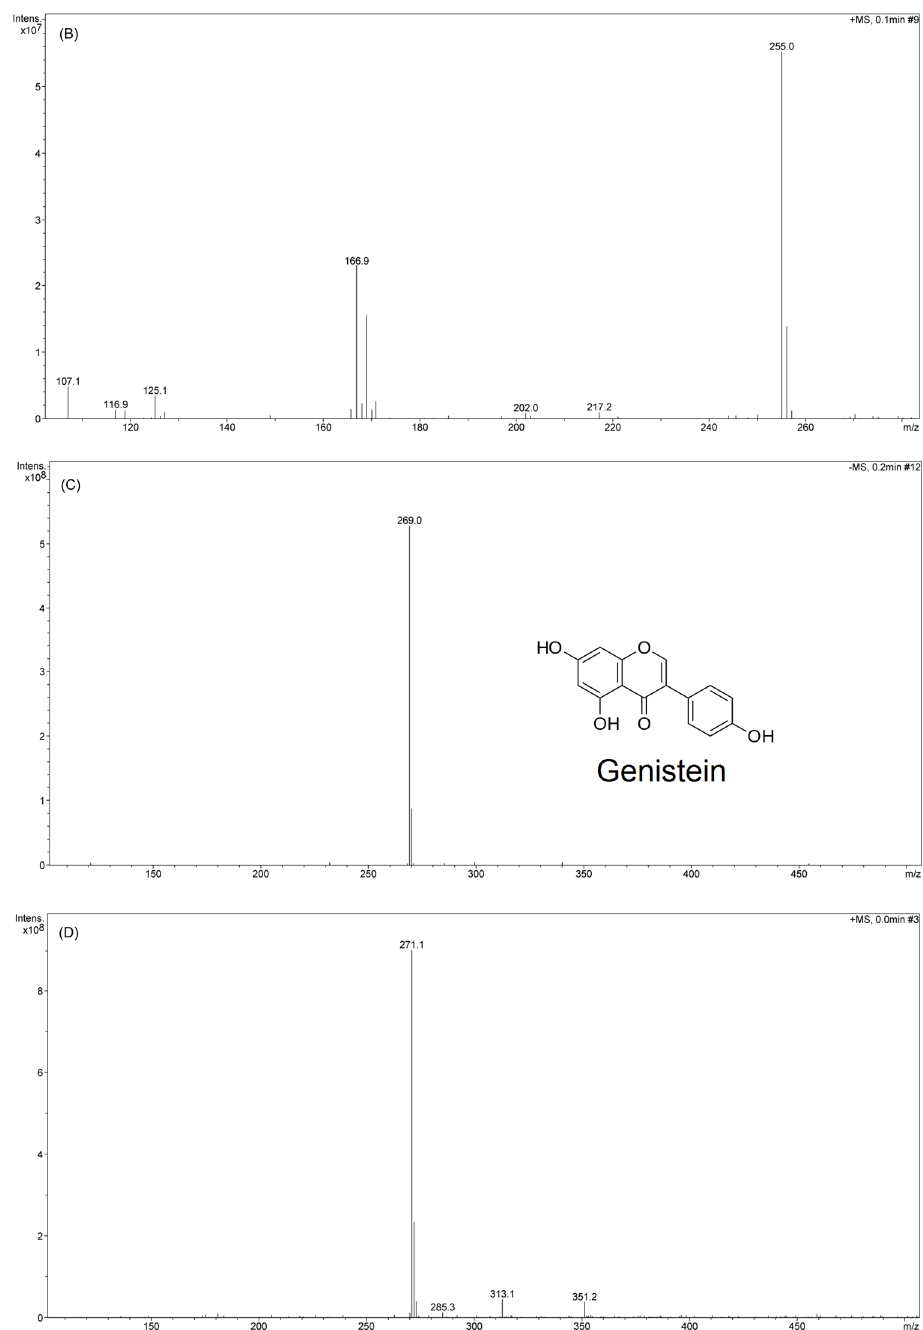
Figure 6. LC-MS / MS spectra of daidzein and genistein. Negative mode of daidzein at m / z 253 ( A ), positive mode of daidzein at m / z 255 ( B ), negative mode of genistein at m / z 269.0 ( C ), and positive mode of genistein at m / z 271.1 ( D